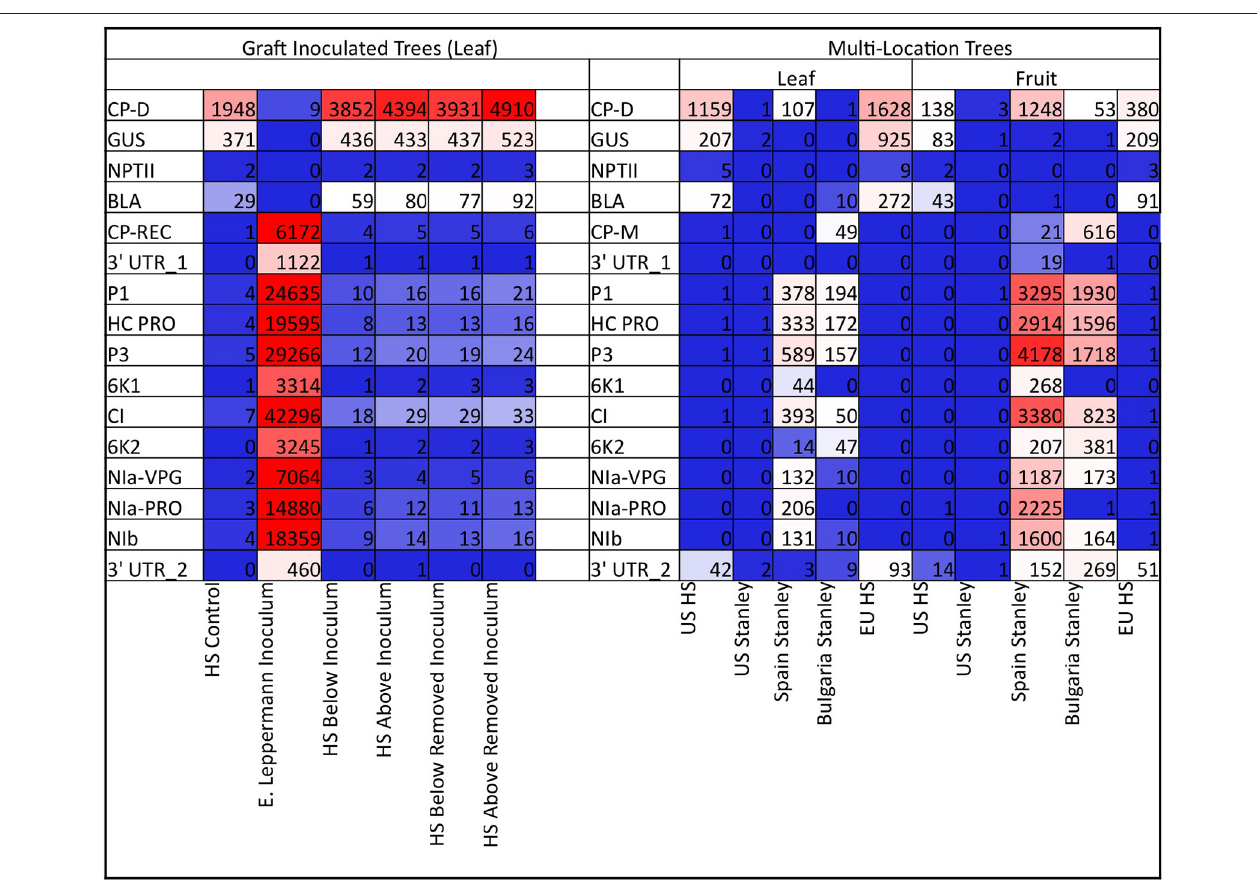
FIGURE 2 | Heatmap of the abundance of sRNAs with homologies to transgenes and PPV viral genes. The number of sRNA reads that matched transgenes (CP-D, GUS, NPTII, BLA) or PPV genes (CP-REC or CP-M, 3 ′ UTR_1, P1, HC-PRO, P3, 6K1, CI, 6K2, Nla-VPG, Nla-PRO, Nib, 3 ′ UTR_2) were tabulated and standardized by amounts per 1 million total sRNA reads. The higher the rate of reads, the more red, and fewer, including no reads, the more blue. The actual number of reads per million is included in each box. The values are an average of the trees under each category. The first set represents the graft-introduced PPV-REC. The six categories are HS control (uninfected ‘HoneySweet,’ one tree), E. Leppermann (‘Emma Leppermann’ infected grafts, four trees), HS below inoculum (‘HoneySweet,’ four trees where leaves were collected below the infected graft), HS above inoculum (‘HoneySweet,’ four trees where leaves were collected above the infected graft), HS below removed inoculum (‘HoneySweet,’ four trees where leaves were collected below where the infected graft had been), and HS above removed inoculum (‘HoneySweet,’ four trees where leaves were collected above where the infected graft had been). The second group is the multi-location ‘HoneySweet’ and ‘Stanley’ (infected and not). The 10 categories are US HS (‘HoneySweet,’ three trees with no PPV exposure), US Stanley (‘Stanley,’ 3 trees with no PPV exposure), Spain Stanley (‘Stanley,’ two trees, positive for PPV-D infection), Bulgaria Stanley (‘Stanley,’ two trees positive for PPV-M infection), and EU HS (‘HoneySweet’ from Spain and the Czech Republic, five trees). Both leaf material and fruit material were analyzed for the related species of sRNA. The map points out that in the graft-challenged experiment, basically only the initially infected ‘Emma Leppermann’ grafts contained sRNAs related to the virus and in the multi-location experiment, the infected ‘Stanley,’ both leaf and fruit were the only ones that had sRNAs related to the virus. In both experiments, ‘HoneySweet’ had sRNAs related to the transgenes, primarily CP and